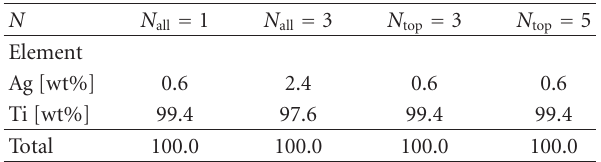
Table 3: Relationship between each element and di ff erent N for Ag- doped TiO 2